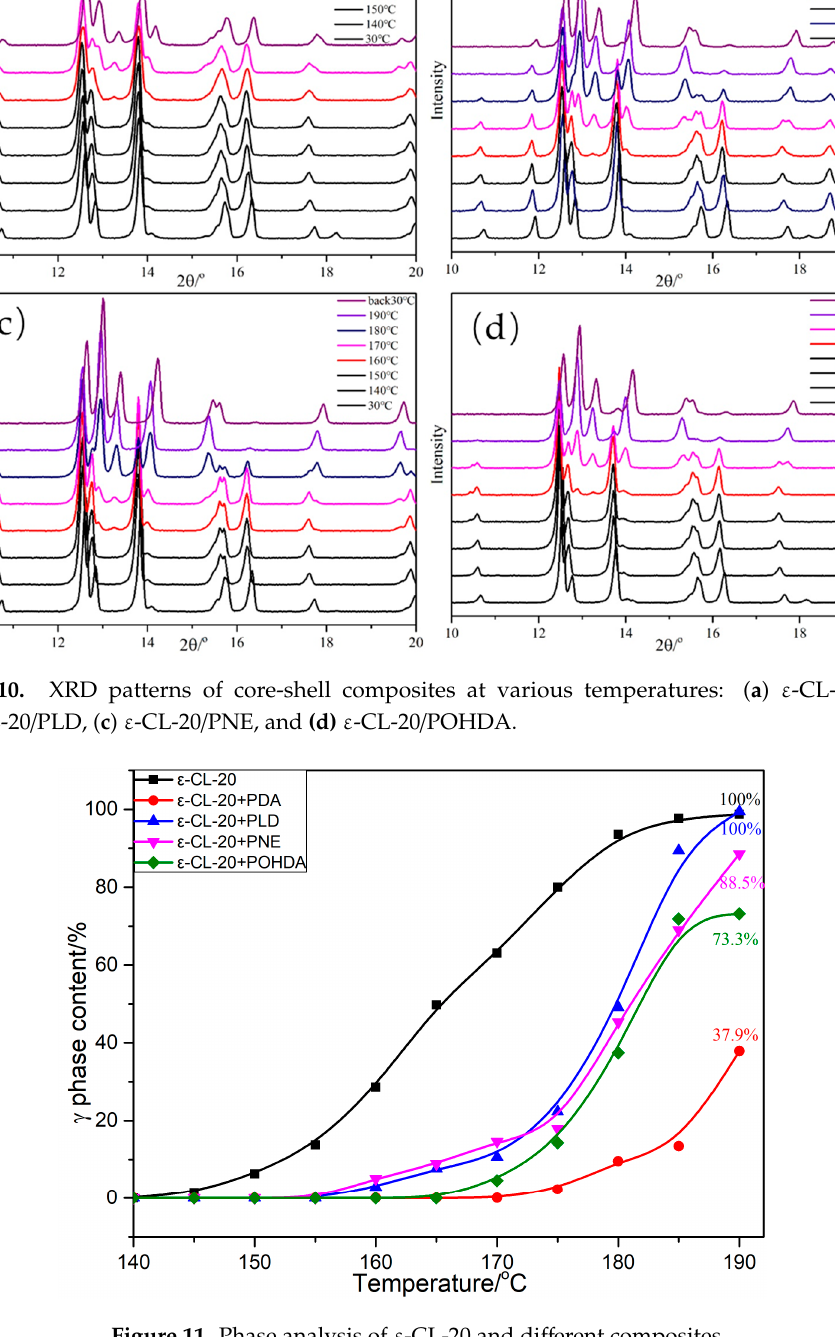
Figure 11. Phase analysis of ε‐ CL ‐ 20 and different composites.